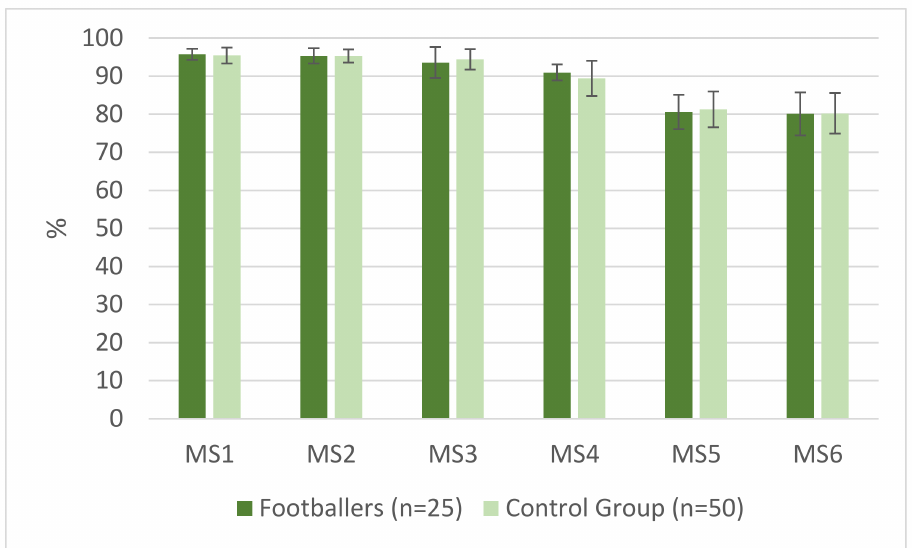
Figure 3. Sensory Organization Test—motor strategy (MS) for particular SOT conditions for footballers and control group.